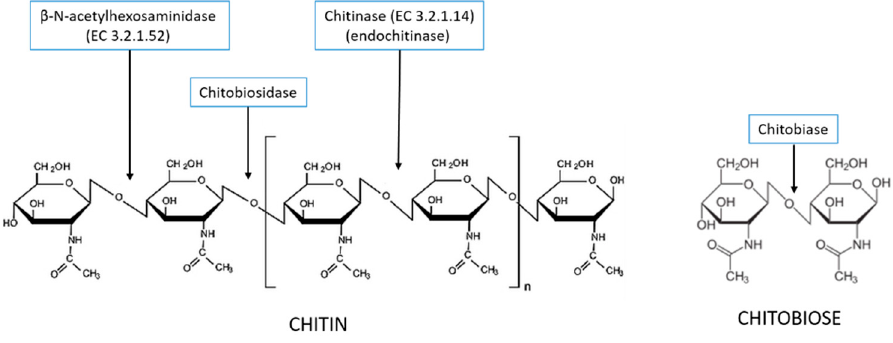
Figure 1. Schematic representation of the catalytic activity by some chitinolytic enzymes on chitin and chitobiose. Only chitinase (EC 3.2.1.14) and β -N-acetylhexosaminidase (EC 3.2.1.52) are described by the Enzyme Commission.